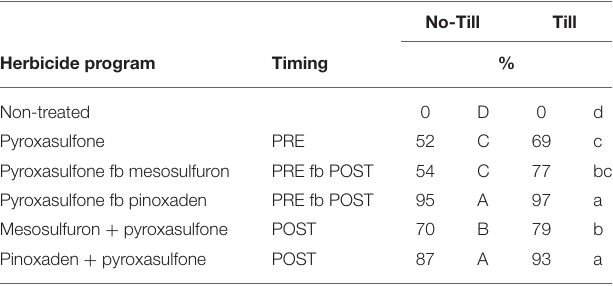
TABLE 3 | Italian ryegrass control prior to winter wheat harvest across both experiment locations (Hertford and Salisbury, North Carolina) and years (2013 and 2014); experiments were separated by tillage